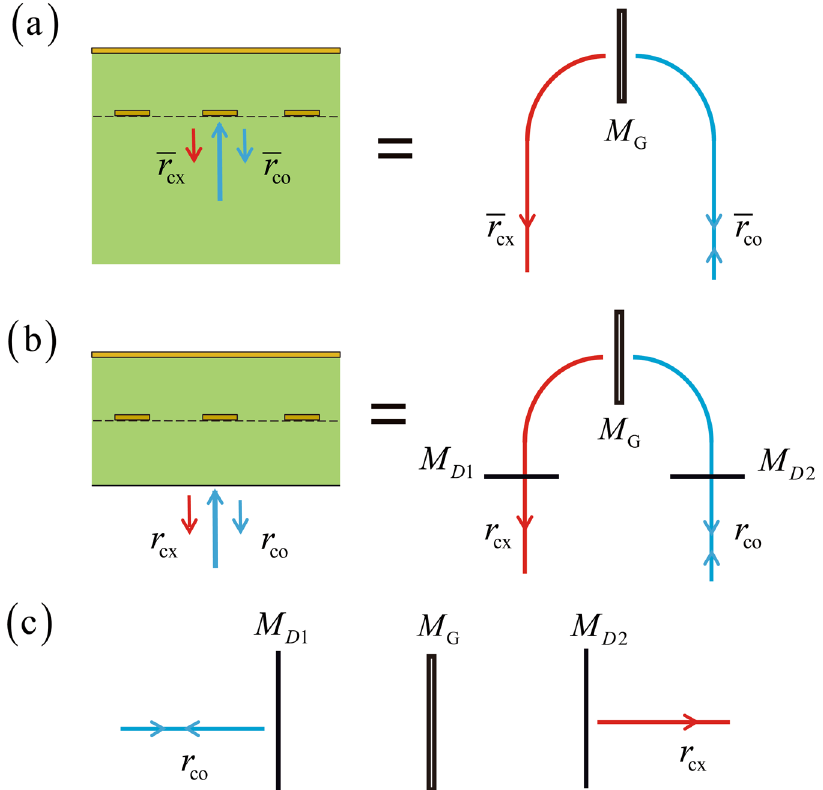
Figure 6. Signal-flow picture for the rigorous analysis of the proposed broadband half-wave plate. ( a ) Case where the grounded dielectric slab has an infinite thickness. ( b ) Case where the grounded dielectric slab has a finite thickness. ( c ) The deduced signal-flow chart for the rigorous analysis of the proposed broadband half- wave plate. Note that the blue and red colors denote the co-polarized and cross-polarized channels